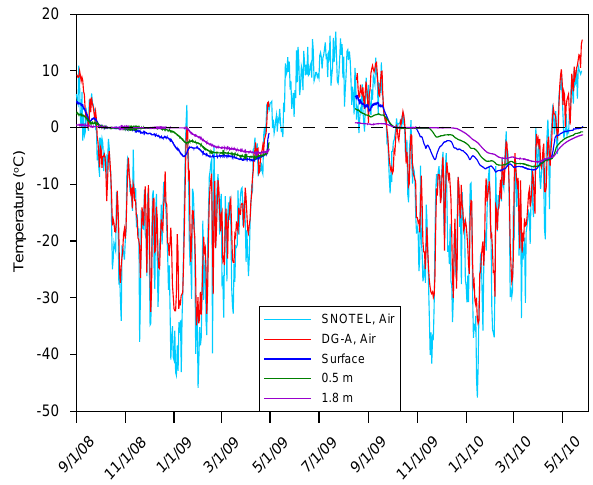
Figure 5. Air and soil temperatures (surface, 0.5, and 1.8 m) for FDL-A.Air temperatures from 2 Fig. 5. Air and soil temperatures (surface, 0.5 and 1.8m) for FDL- the SNOTEL weather station in Coldfoot are included for comparison. 3 A.Air temperatures from the SNOTEL weather station in Coldfoot are included for comparison.